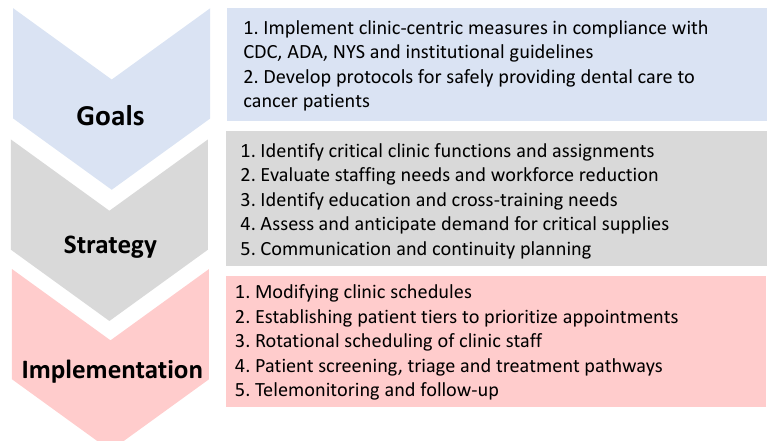
Figure 1. Schematic overview of the responsiveness of the Dentistry and Maxillofacial Prosthetics (DMFP) clinic at Roswell Park Comprehensive Center to the pandemic. (CDC—Centers for Disease Control and Prevention; ADA—American Dental Association; NYS—New York State).